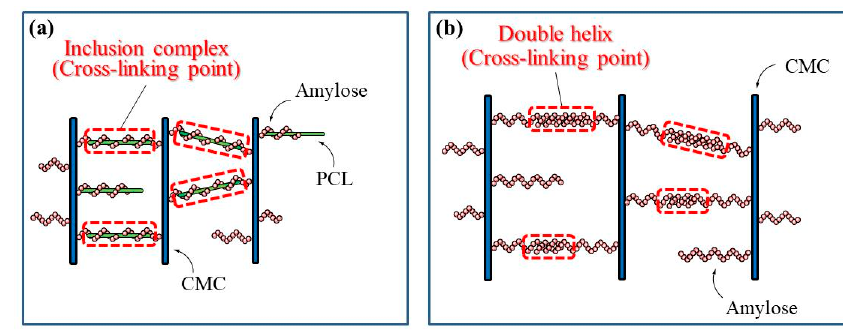
Figure 6. Images for ( a ) smaller and ( b ) larger network structures cross-linked by inclusion complexes and double helixes, respectively.